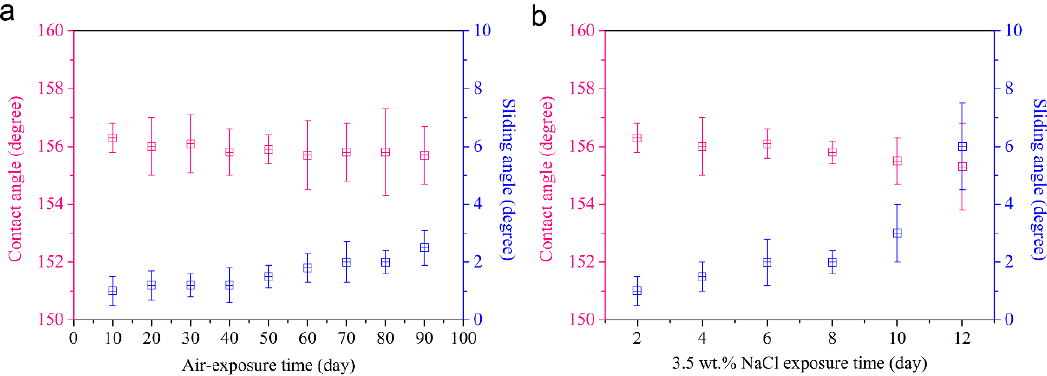
Figure 10. The variation of the contact angle and sliding angle under different exposure time in ( a ) air and ( b ) 3.5 wt.% NaCl aqueous solution.